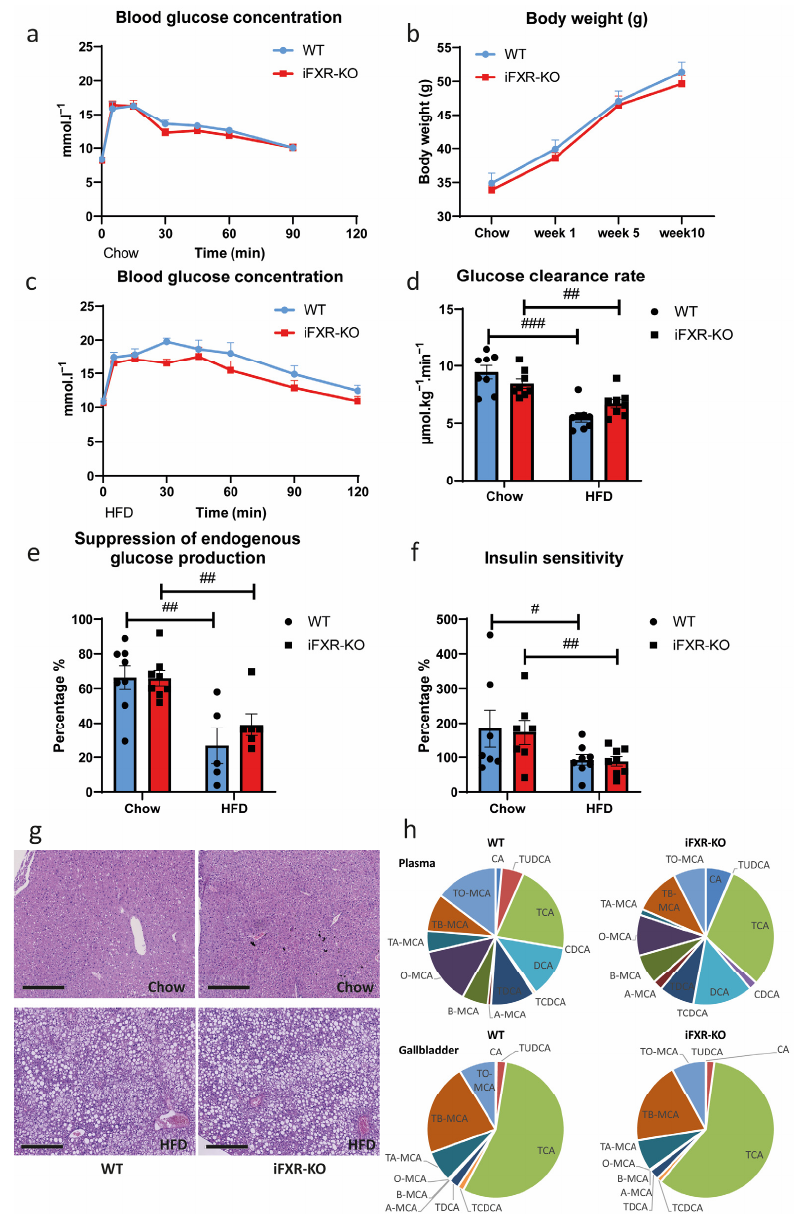
Figure 3. Long-term HFD exposure leads to impaired glucose metabolism in both WT and iFXR-KO mice. ( a ) Blood glucose concentration at 0, 5, 15, 30, 45, 60 and 90 min during glucose absorption test of wild-type (WT) and intestine-specific FXR − / − (iFXR-KO) mice on chow diet; ( b ) Body weight change of WT and iFXR-KO mice during the period of 10-week high-fat-diet (HFD) feeding; ( c ) Blood glucose concentration at 0, 5, 15, 30, 45, 60, 90 and 120 min during glucose absorption test of WT and iFXR-KO mice after 10-week HFD; ( d ) Glucose clearance rate, ( e ) hepatic glucose suppression and ( f ) insulin sensitivity of WT and iFXR-KO mice during glucose absorption test on chow and on 10-week HFD; ( g ) Representative image of H&E staining of liver from WT and iFXR-KO mice on chow or on 10-week HFD (magnification 8x; bar represents 300 µ m); ( h ) Relative bile acid composition in plasma and gallbladders from WT and iFXR-KO mice on 10-week HFD. CA: cholic acid, (T)CDCA: (tauro)chenodeoxycholic acid, TUDCA: tauroursodeoxycholic acid, (A,B,O)MCA: ( α , β , ω )muricholic acid, TMCA: tauromuricholic acid, TCA: taurocholic acid, DCA: deoxycholic acid. Statistical significance was determined using the Mann–Whitney test in WT and iFXR-KO mice. All panels: n = 6–9/group, data are represented as mean ± SEM, # p < 0.05, ## p < 0.01 and ### p < 0.001 when WT mice on chow condition compared with HFD